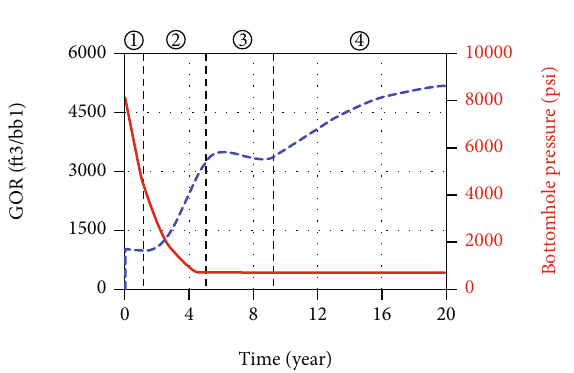
Figure 6: Simulation results of the base model GOR behavior. Four stages can be clearly observed, consistent with the pressure drawdown pro fi le.